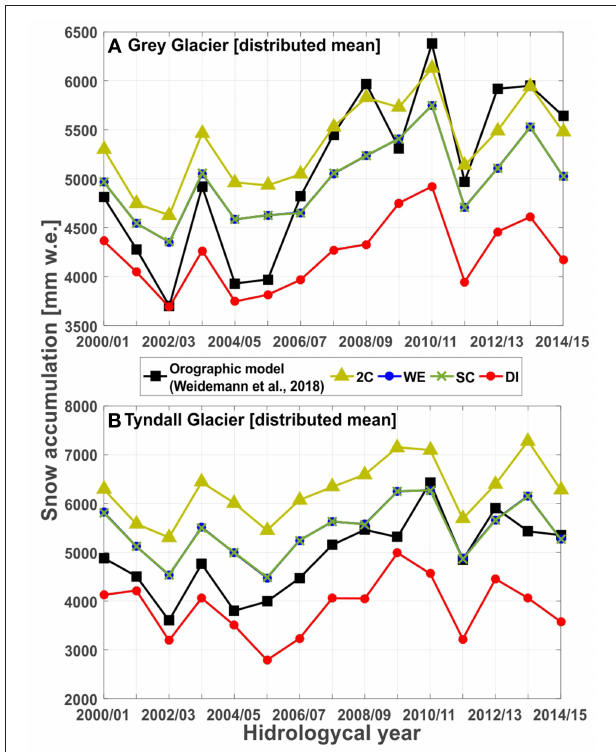
FIGURE 8 | Comparison of annual snow accumulation using the four PPMs and estimates from Weidemann et al. (2018). (A) Distributed mean at Gray Glacier, and (B) distributed mean at Tyndall